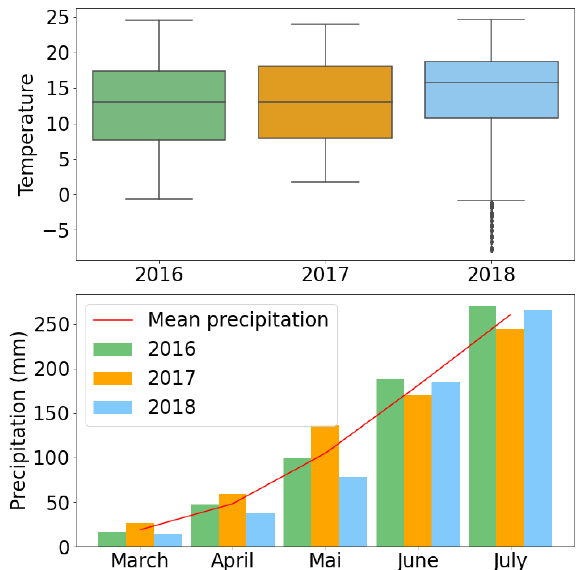
Figure 2. Data on average temperature for each year and an overview of monthly precipitation. Climatological data from March to July were used for the visualisation.